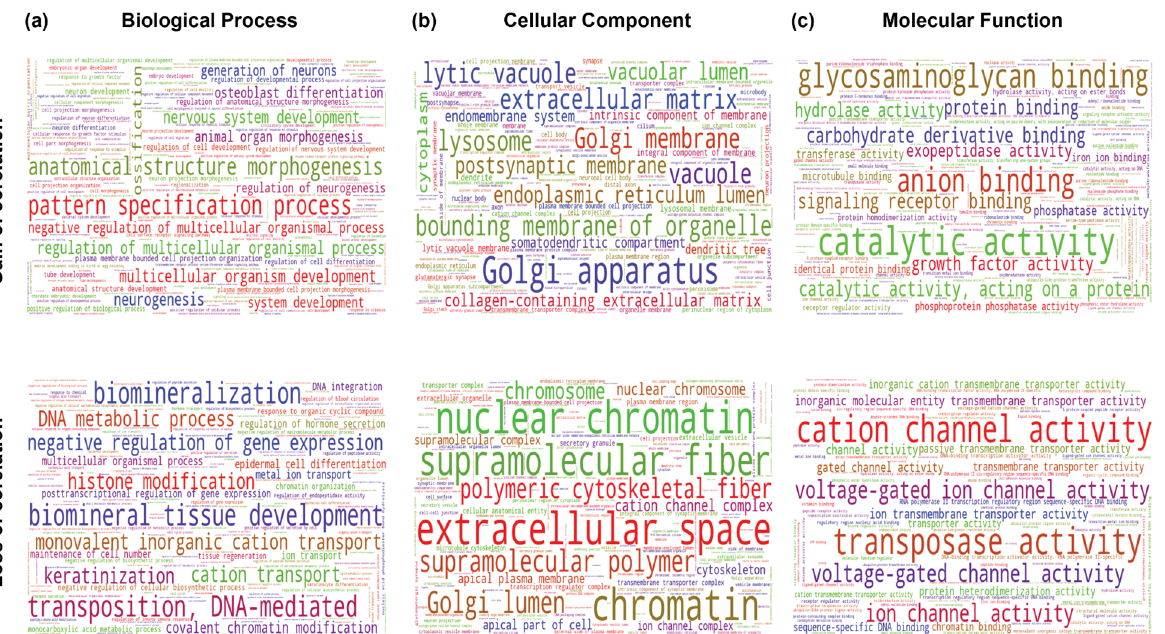
Figure 13. Gene Ontology analysis of genes differentially correlated with THAP9-AS1 in normal vs. tumor samples (top—genes that gained correlation with THAP9-AS1; bottom—genes that lost correlation with THAP9). Word clouds of enriched ( a ) GO biological process, ( b ) GO cellular component, and ( c ) GO molecular functions. The differential gene correlation analysis, followed by